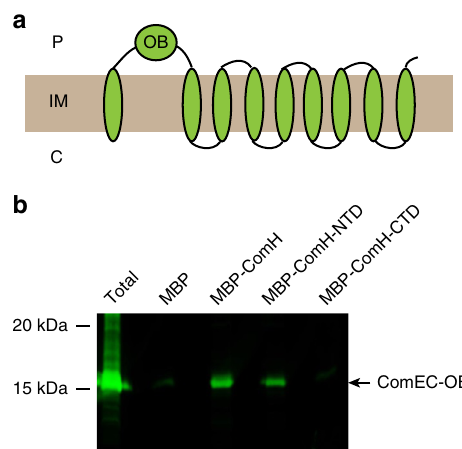
Fig. 6 ComH interacts with the OB domain of ComEC. a Schematic representation of the predicted topology of H. pylori ComEC as described in ref. 35 . P = periplasm; C = cytoplasm; IM = inner-membrane; OB = Oligonucleotide binding domain. b MBP pull-down assay demonstrating the interaction between E. coli expressed ComEC-OB-His 6 and MBP-ComH or MBP-ComH-NTD. The presence of ComEC-OB-His 6 in the fractions eluted from the amylose resin was detected by Western blots using anti-His